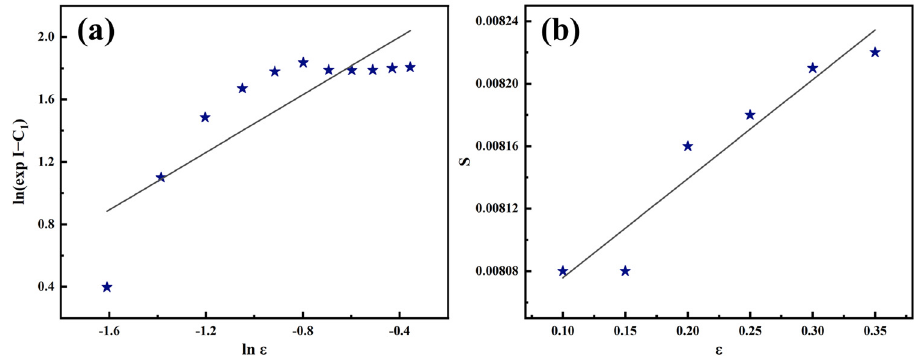
Figure 11. Parameter relationship fitting related to I and S ( a ) ln ε ‐ ln(expI − C 1 ); ( b ) ε‐ S. Taking the logarithm of Equation (13)